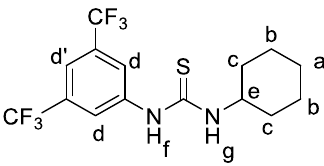
Figure 7. Thiourea structure. 1 H NMR (400 MHz, DMSO- d6, ppm): δ = 1.44 (m, 4H, H c ), 1.5-1.99 (m, 4H, H b ), 2.66